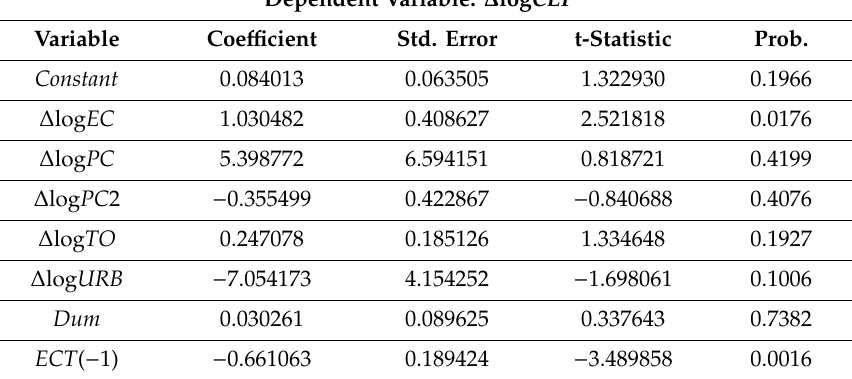
Table 4. Results of